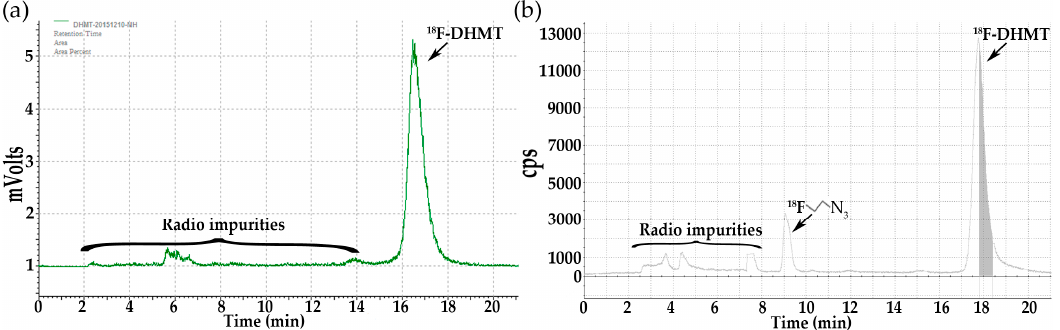
Figure 1. Semi-preparative radio-HPLC chromatograms for purification of [ 18 F]DHMT ([ 18 F] 5 ). ( a ) Manual method; ( b ) Automated method.